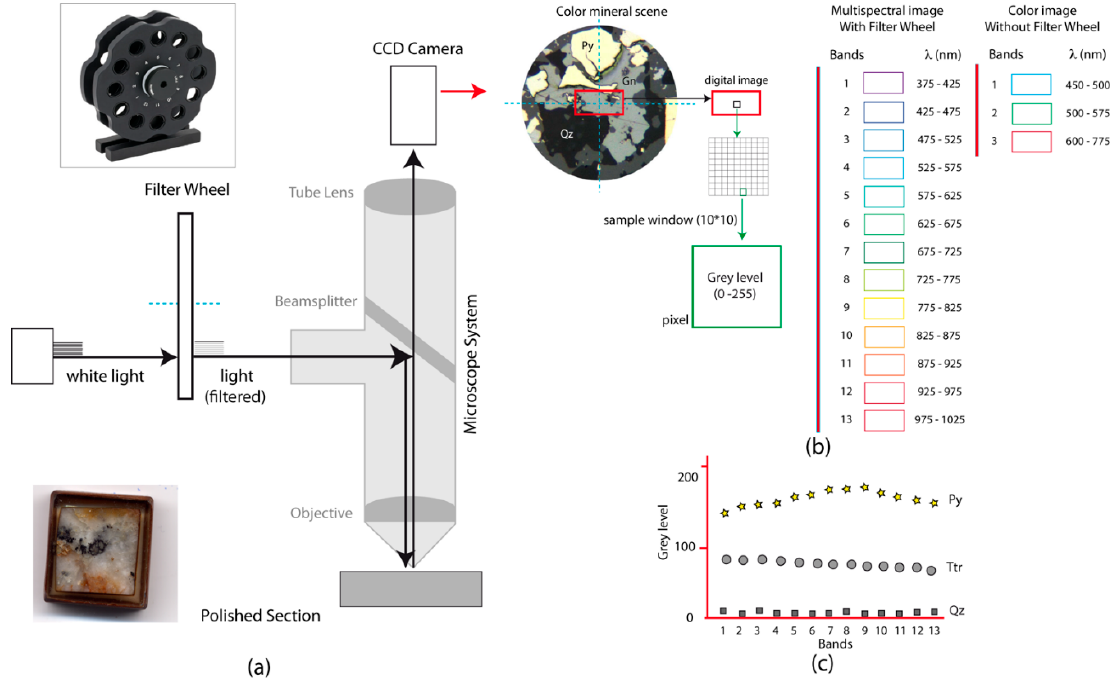
Figure 3. Diagram of the experimental setup: ( a ) Configuration of reflected microscopy, filter wheel and CCD camera for multispectral image analysis. ( b ) An example of an optical reflection microscopic image with an example of sample window of 10×10 pixels. Multispectral and RGB bands with related wavelengths associated. ( c ) Grey level values from Py, Ttr and Qz plotted against bands (13 wavelengths). Mineral abbreviations follow [50].